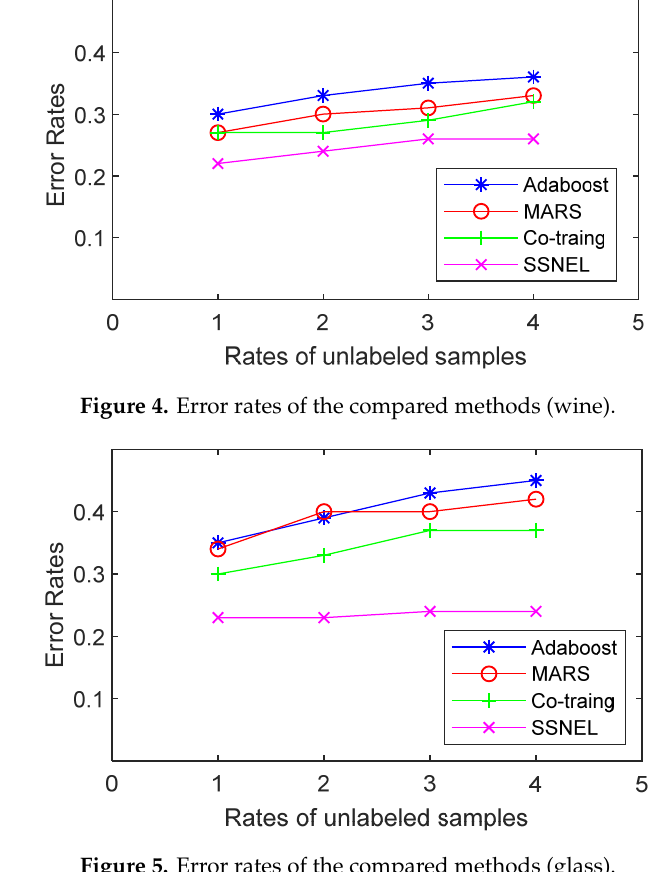
Figure 5. Error rates of the compared methods (glass).